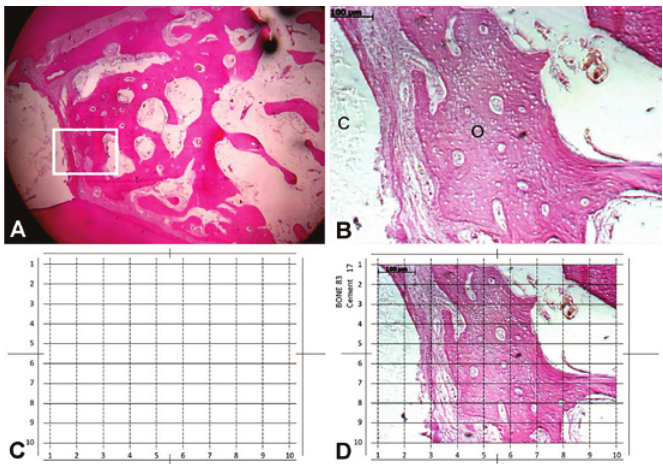
FIGURE 2 – ( A ) Micrograph of a furcation perforation treated with white Portland cement. Image detail shows the obturation cement and newly formed bone. Hematoxylin and Eosin stain, magnification 5x. ( B ) Enhanced image detail showing the obturation cement ( C ) and newly formed bone ( O ). ( C ) Image of the 10 x 10 square grid containing 100 points used in the study. ( D ) Grid placed over the digital image for counting grid points positioned on the structures identified in the